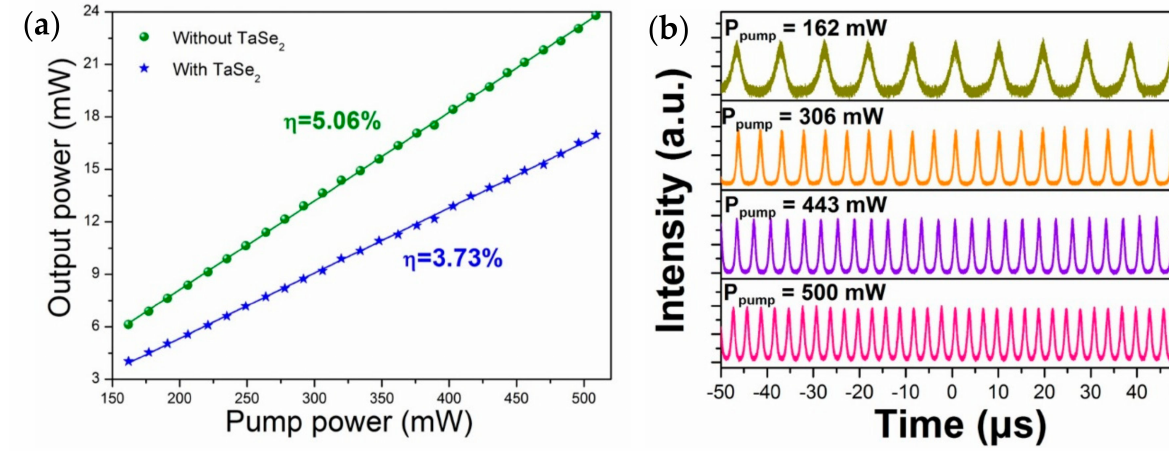
Figure 7. ( a ) Output power versus pump power with TaSe 2 (green dots) and without TaSe 2 (blue stars). ( b ) Stable pulse trains with different pump power